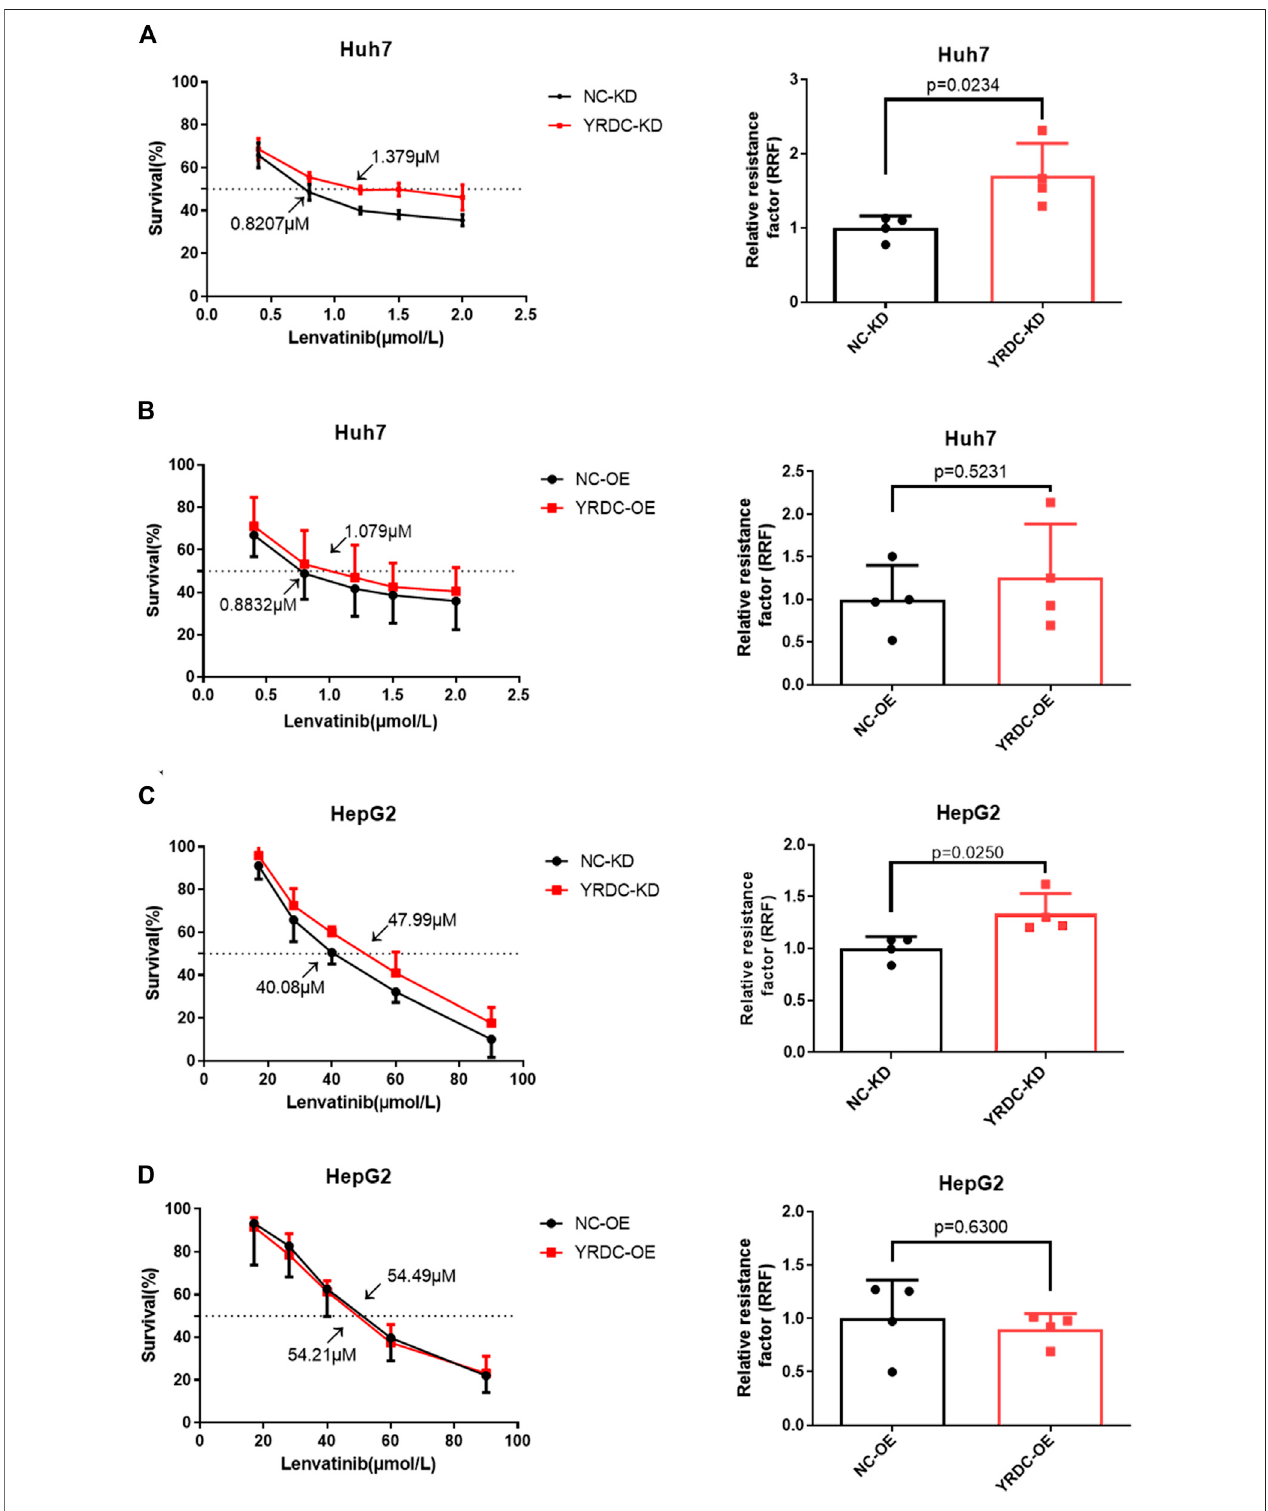
FIGURE1| Theknockdown ofYRDC attenuates cellular sensitivity tolenvatinib in invitro cellviabilityassay. (A, B) YRDC stable knockdown and overexpressionin Huh7 cell were subjected to treatment with lenvatinib at various concentrations. The half maximal inhibitory concentration (IC 50 ) was calculated by GraphPad Prism six software from four independent experiments. The relative resistance factor (RRF) of lenvatinib was calculated by dividing the IC 50 of the control cells and by that of the cells with YRDC knockdown or overexpression. (C, D) YRDC stable knockdown and overexpression in HepG2 cell were subjected to treatment with lenvatinib at various concentrations. Dots in the graphs mean biological repetitions, n (cid:2) 4.